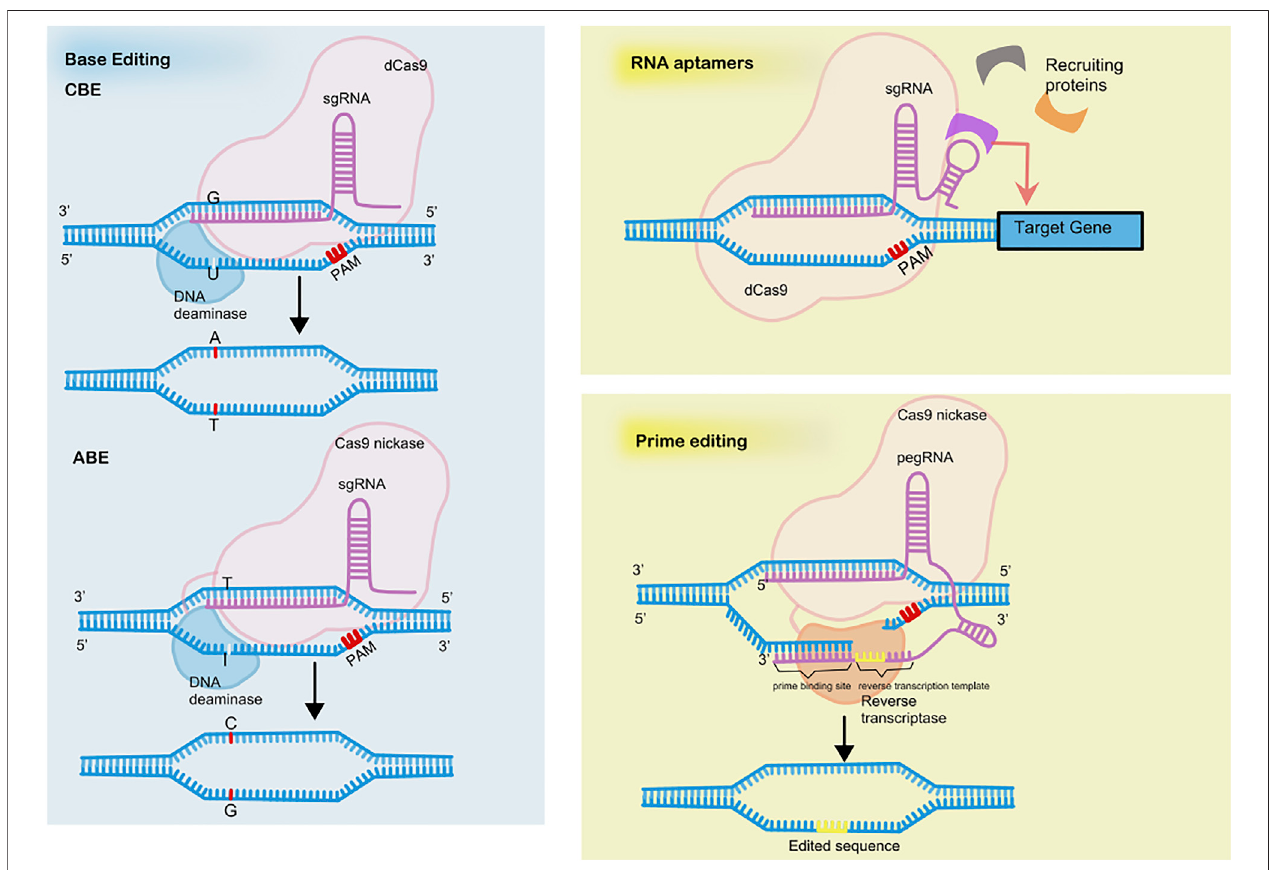
FIGURE 2 | The mechanisms of base editing, prime editing and RNA aptamers.